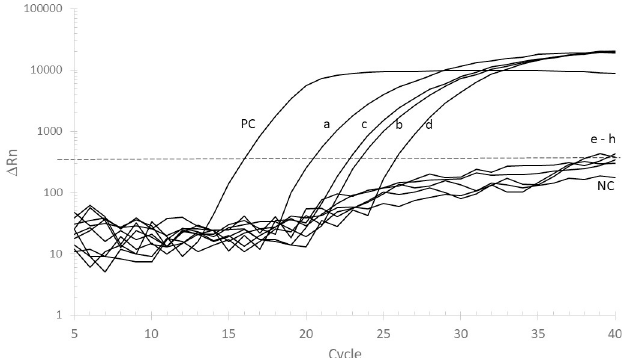
Fig 2. Representative traces of the qPCR amplification of M . tuberculosis IS 6110 target. Porcine mucin samples spiked with M . tuberculosis H37Rv DNA (25 ng/ μ L) were processed according to protocols #3 or #4. Traces “a” and “b” were obtained after 1:10 and 1:100 dilution of the eluted DNA obtained with protocol #3. Traces “c” and “d” were obtained after 1:10 and 1:100 dilution of the eluted DNA obtained with protocol #4. “PC” and “NC” represent the positive control (25 ng/ μ L of DNA extracted from H37Rv MTB cells) and the negative control (TE pH 8.0), respectively. Traces “e”, “f”, “g”, and “h”, (“e–h”) represent 1:100 dilutions of protocols #1, #2, #5, and #6. Traces are representative of at least three independent extraction